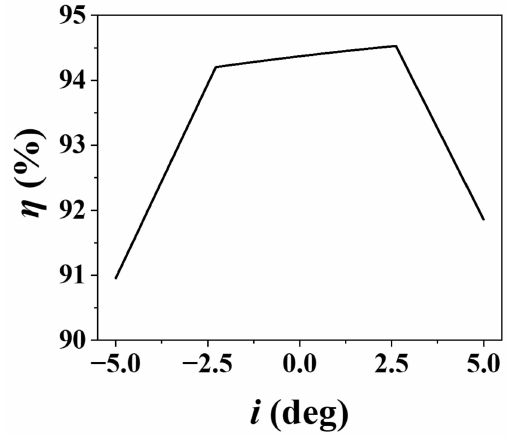
Figure 13. Luminous flux utilization as a function of i when ω = 0 ◦ .